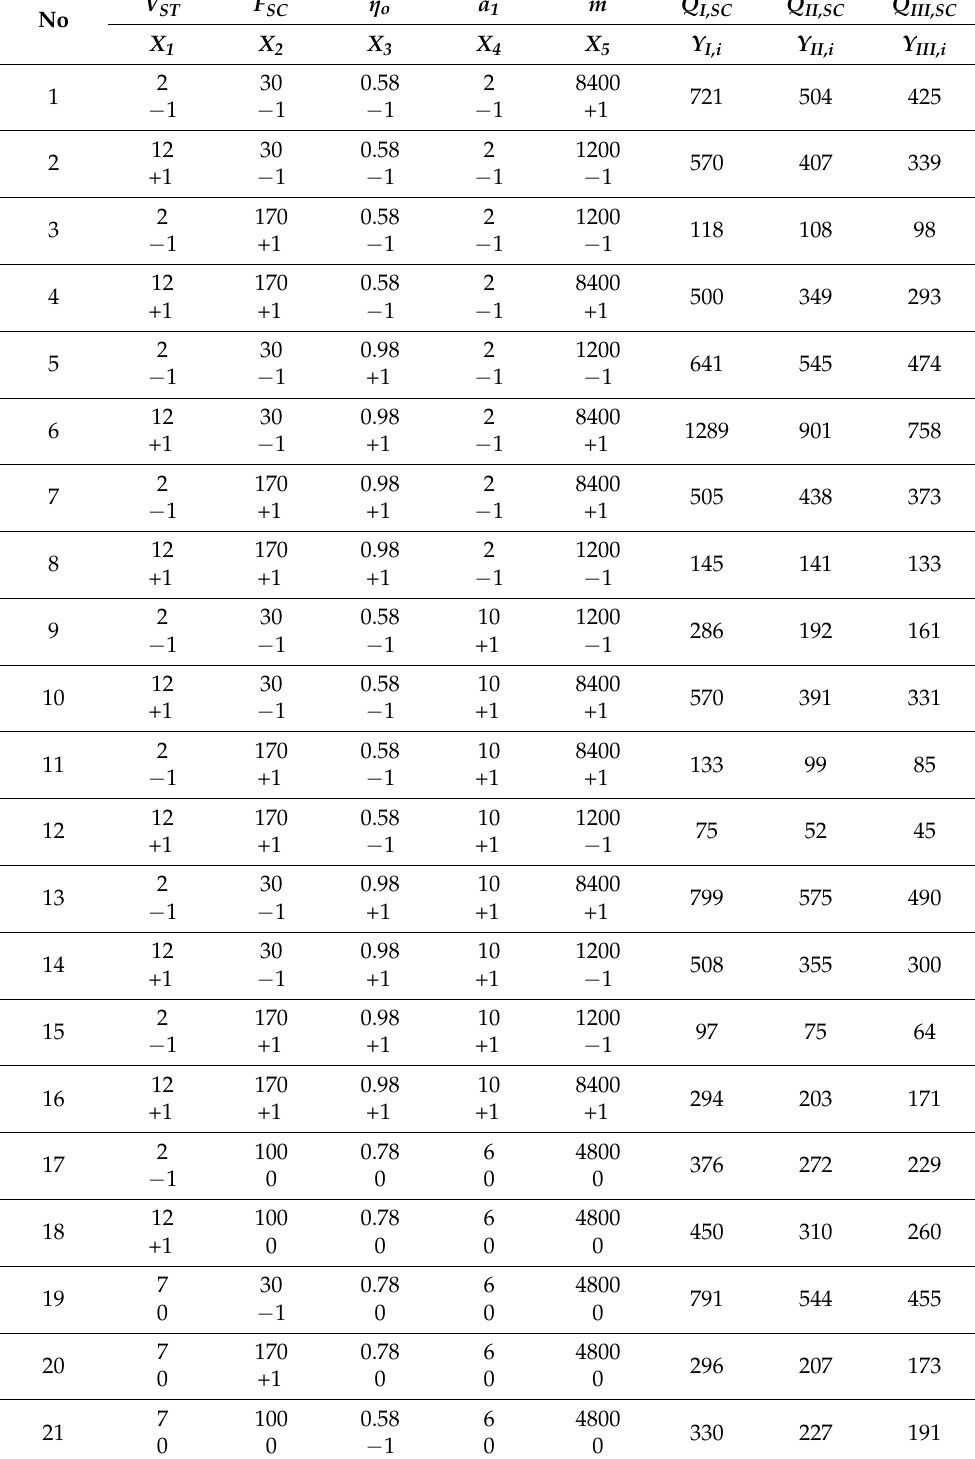
Table 5. Planning matrix and calculation results of annual useful energy output [kWh/m 2